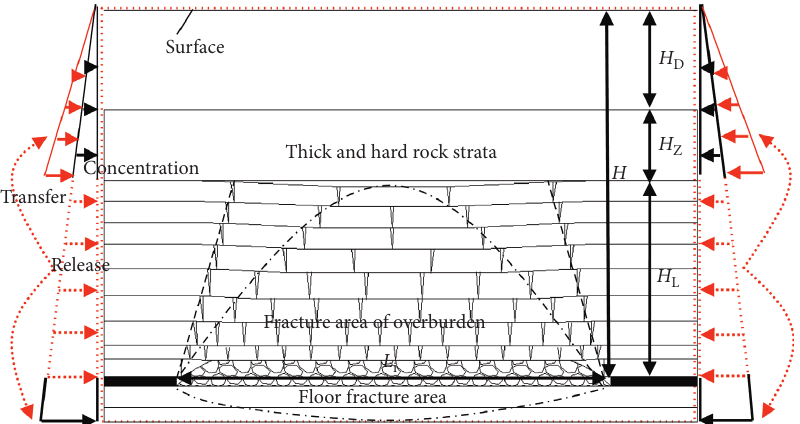
Figure 9: Simplified model of the overburden fractures and horizontal stress transfer in the stope.